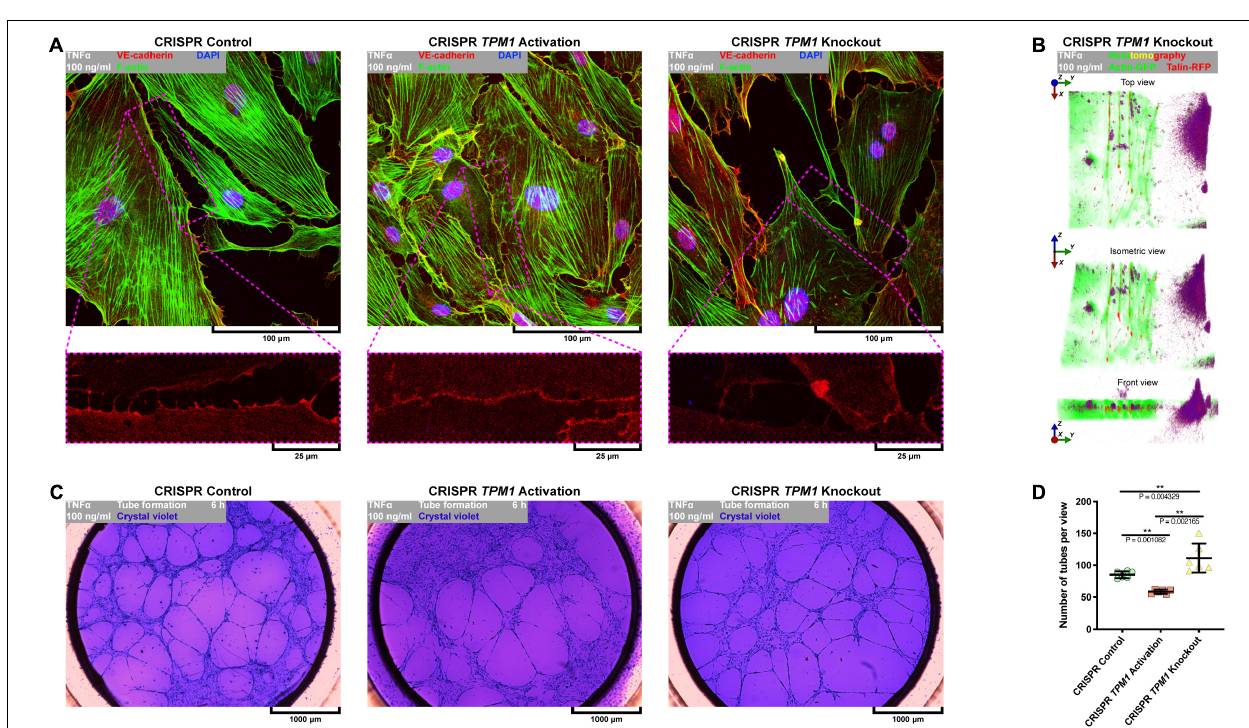
pHCAECs (from 0.516 ± 0.0293 to 0.824 ± 0.1143, p =